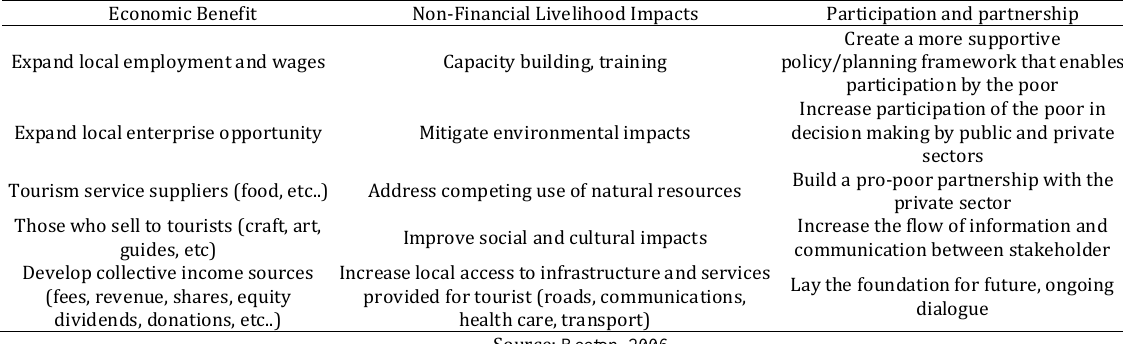
Table 1 Advantages of Pro-poor Tourism